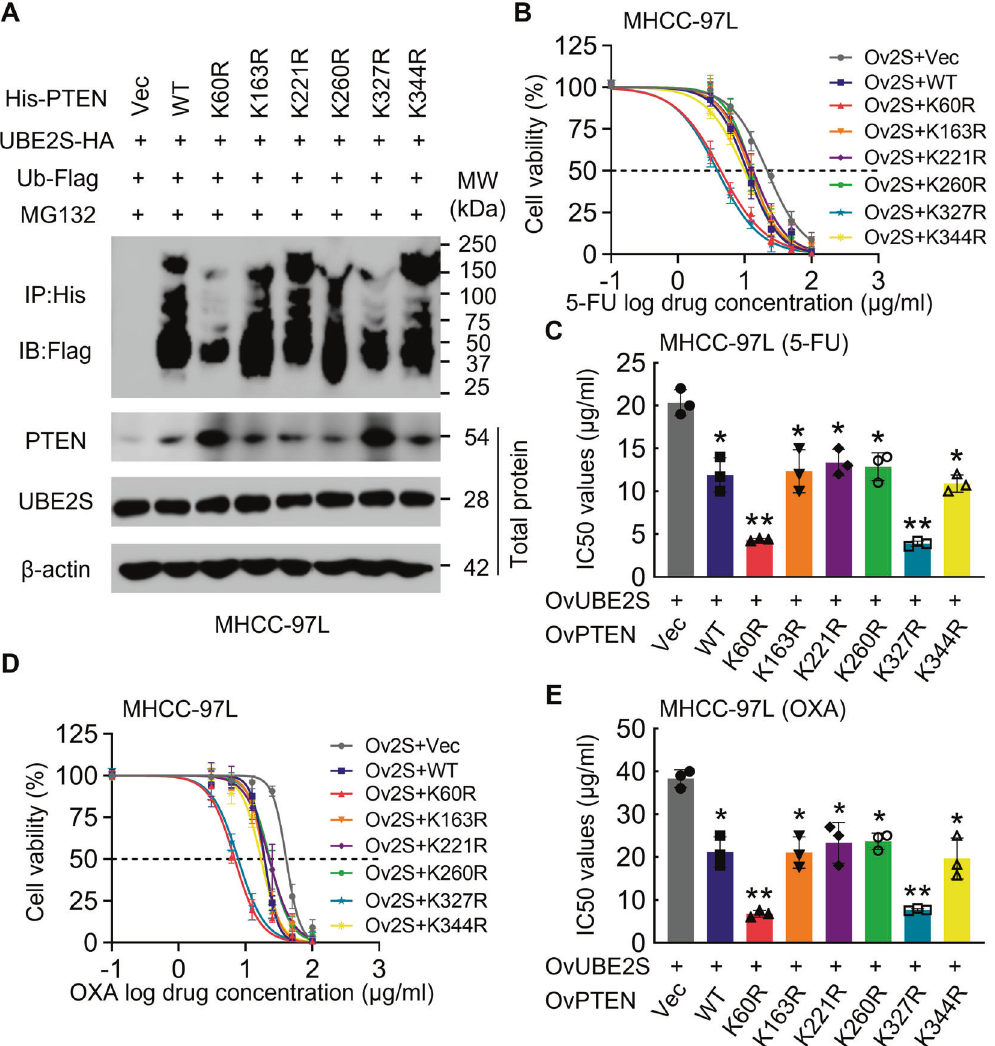
Fig. 6 UBE2S ubiquitinates PTEN at Lys60 and Lys327. A MHCC-97L cells overexpressed indicated proteins were treated with MG132 (10 μ M) for 8 h, and the ubiquitination levels of PTEN protein were investigated. B – E MHCC-97L cells infected with indicated lentiviral plasmids. The cytotoxic effects upon 5-FU ( B , C ) and oxaliplatin ( D , E ) were investigated ( n =